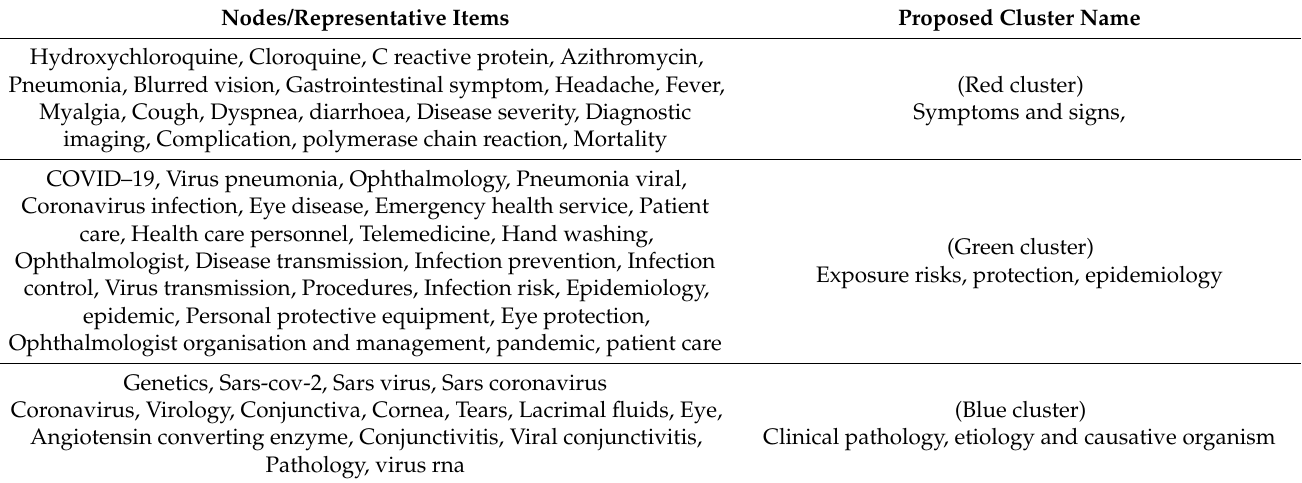
Table 6. Proposal of names for the clusters formed by VOSviewer based on their degree of relatedness. Word cluster colors match those employed in Figure